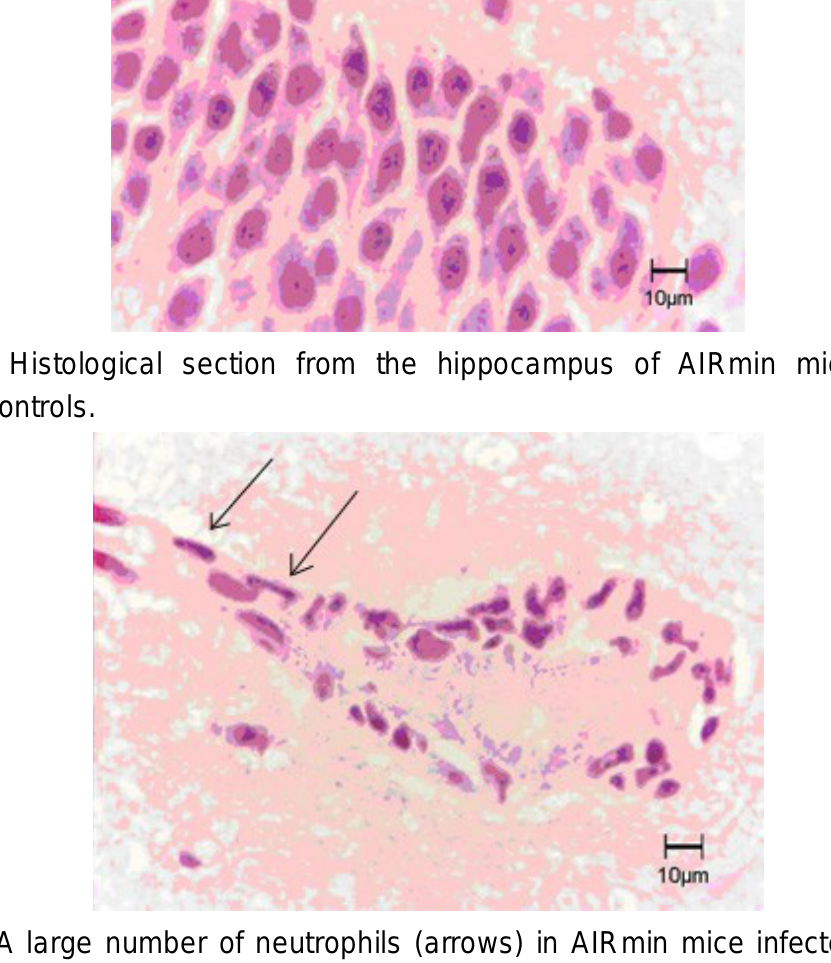
Figure 5: A large number of neutrophils (arrows) in AIRmin mice infected with PV1 43/4